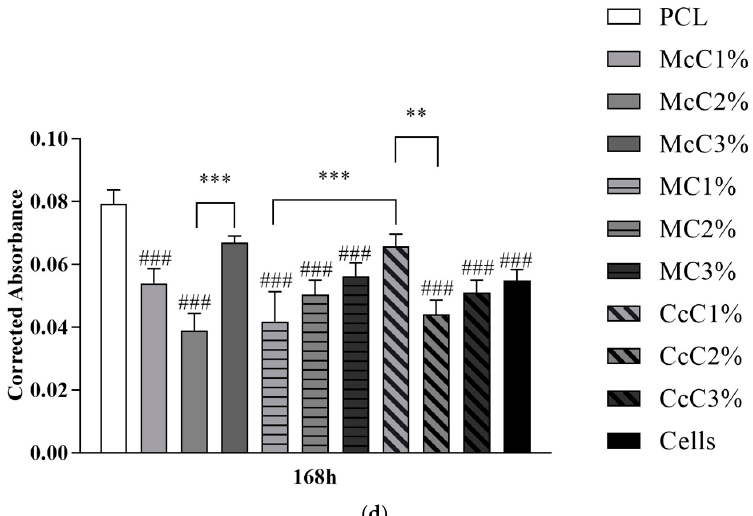
Figure 7. Cytocompatibility between scaffolds and hDPSCs using the PrestoBlue TM viability assay, determined at: ( a ) 24 h; ( b ) 72 h; ( c ) 120 h; ( d ) 168 h. Results are expressed in Mean ± Standard Error of the Mean (SEM). Differences were considered statistically significant at p < 0.05. Results significances between different scaffolds were presented using the symbol (*). Differences between scaffolds and PCL were presented using the symbol (#). According to the p -value, *(#), **(##), and ***(###) corresponds to p < 0.05, p < 0.01, and p < 0.001, respectively.